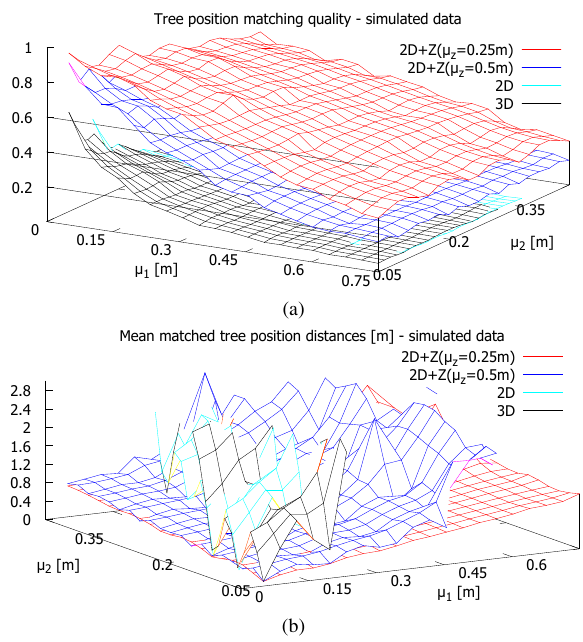
Figure 7: Results for simulated data as a function of tree posi- tion noise means: (a) avg. correctly matched point ratio, (b) avg. matched point distance [m]. µ z indicates vertical noise mean.